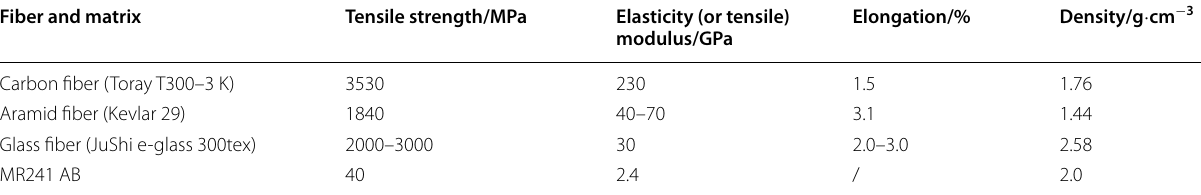
Table 1 Material properties of the fiber rayon and matrix Fiber and